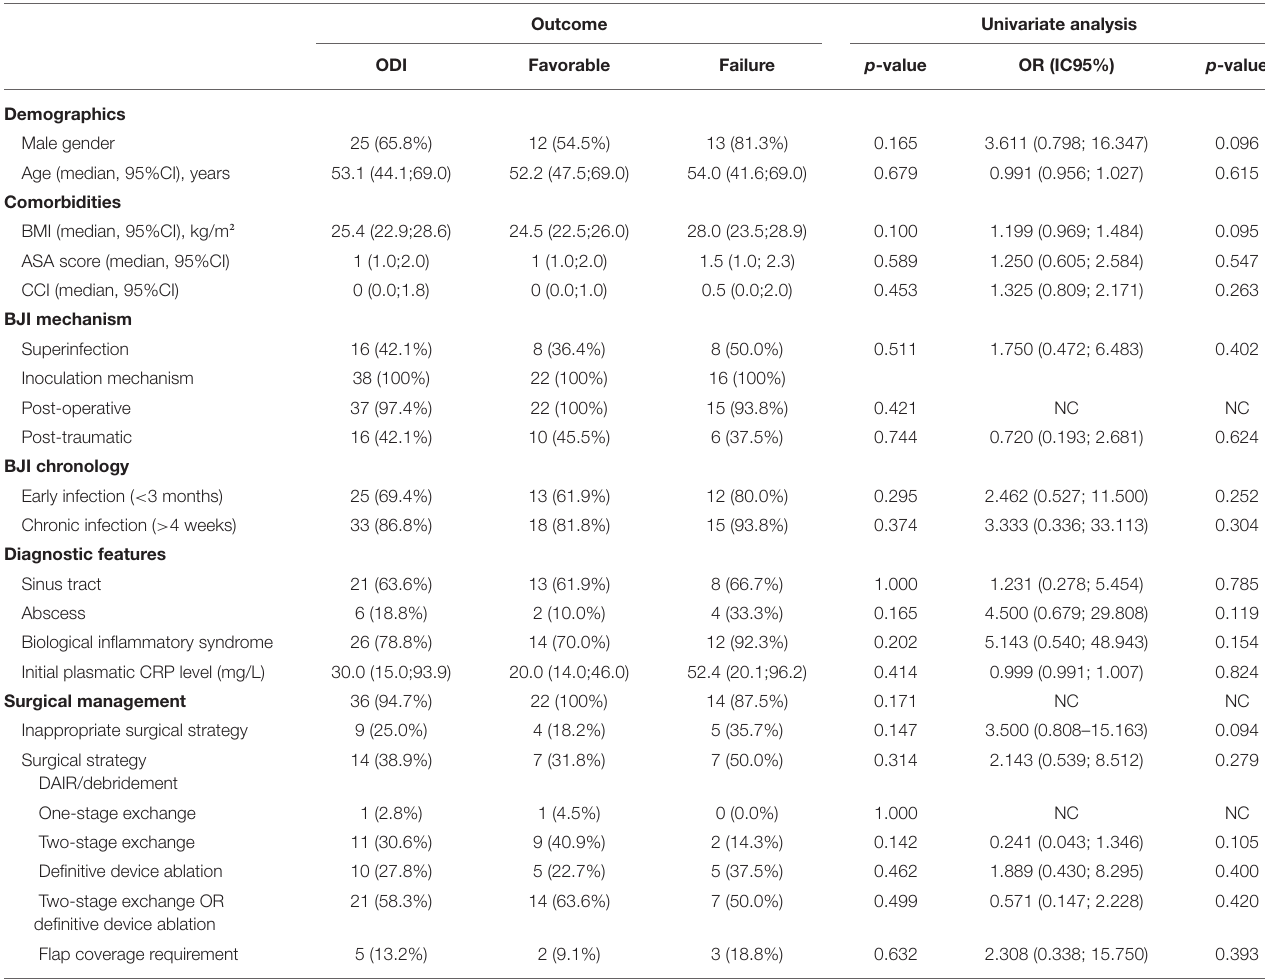
TABLE 2 | Comparison of patients with favorable and unfavorable outcome and determinants of treatment failure in patients with Corynebacterium spp. orthopedic device-related infection (univariate analysis). Outcome Univariate analysis ODI Favorable Failure p -value OR